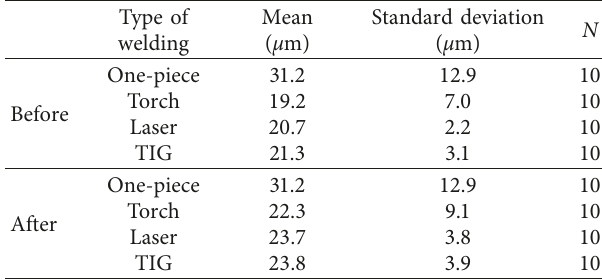
Table 1: Mean and standard deviation of the marginal discrepancy ( μ m) associated with the different techniques before and after welding.